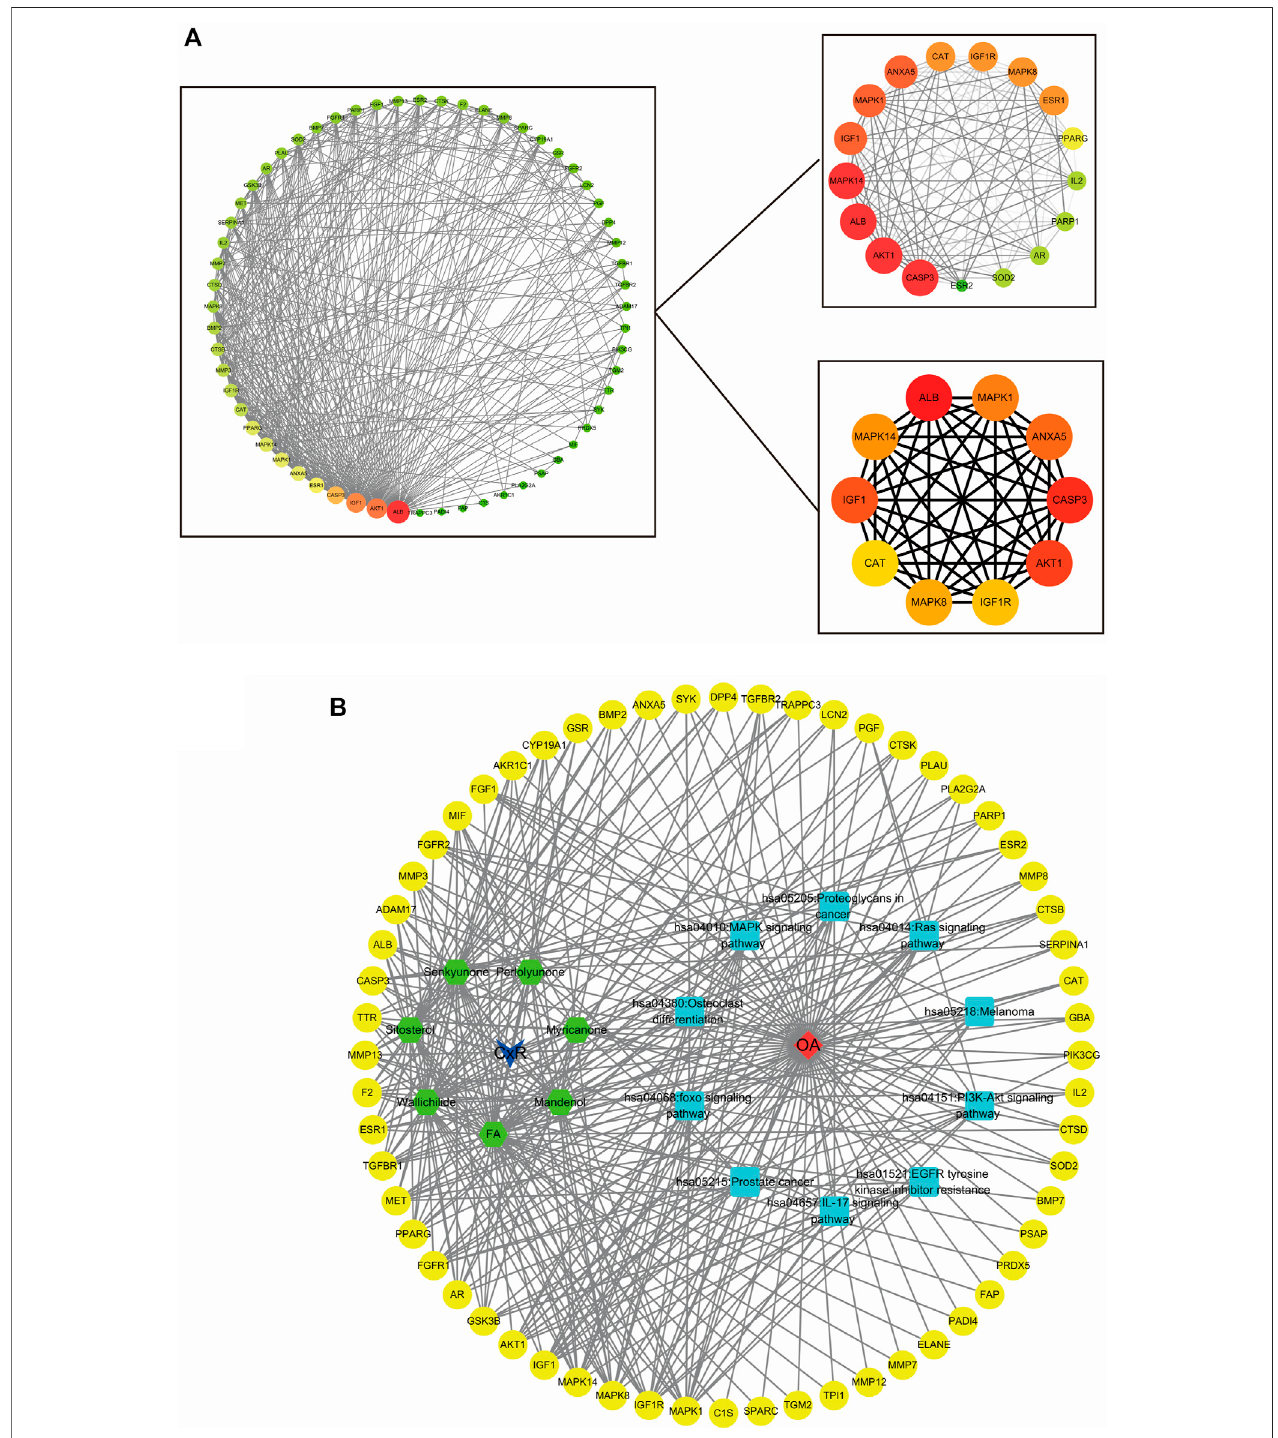
FIGURE4 | Plug-inof Cytoscape wasused toselect the molecular complexesand core targets and the D-C-T-P-D network (A) MCODE and CytoHubba plug-ins of the Cytoscape software were used to choose the molecular complexes and core targets, respectively. (B) The drug-compound-target-pathway-disease network showed the potential mechanism of CX to treat